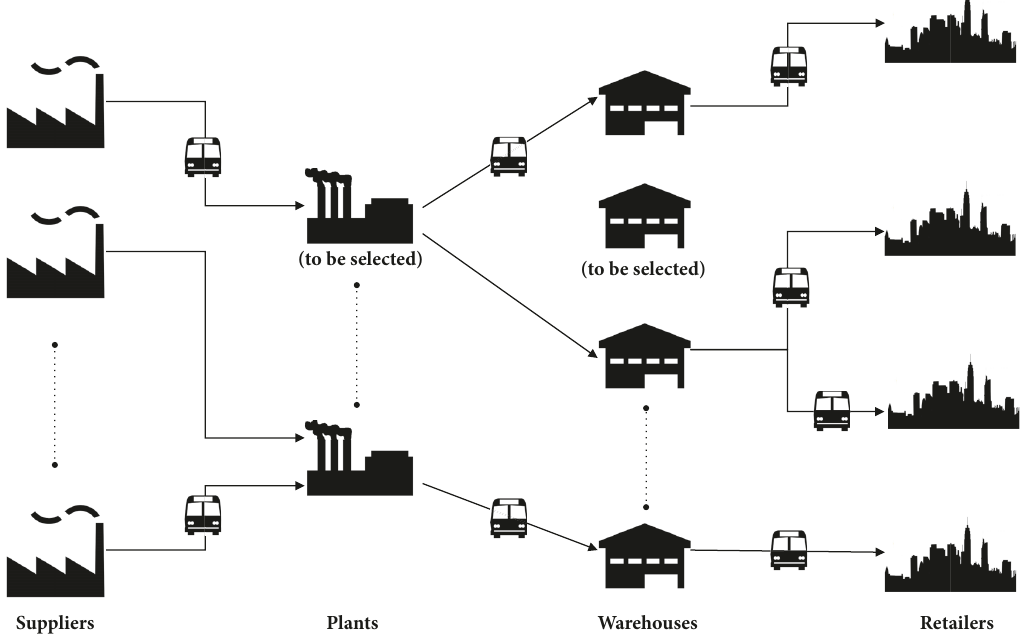
Figure 1: Four-echelon supply